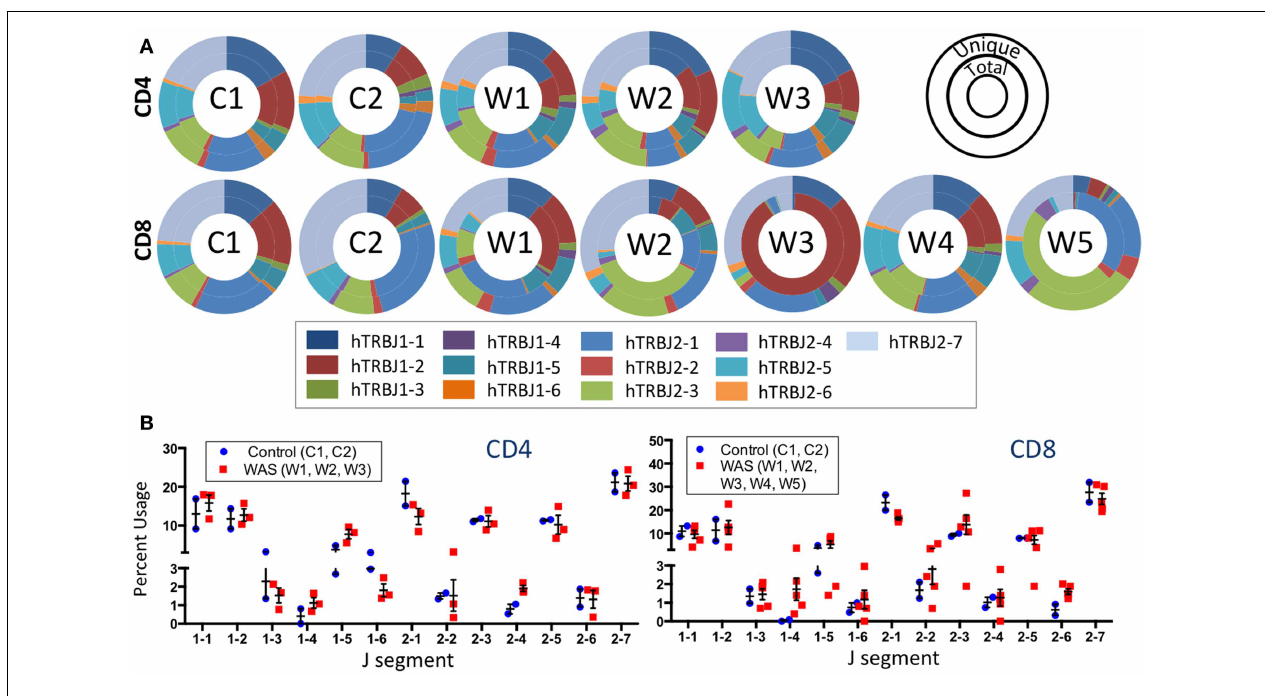
ring) sequences for controls andWAS patients (see also inset key). (B) Direct comparison of J segment usage betweenWAS patients and controls.